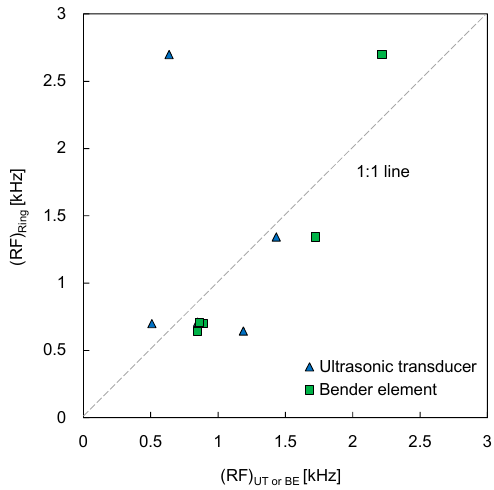
Figure 10. Comparison of resonant frequency obtained from the ring bender with ultrasonic trans- ducer and bender element. RF denotes the resonant frequency.